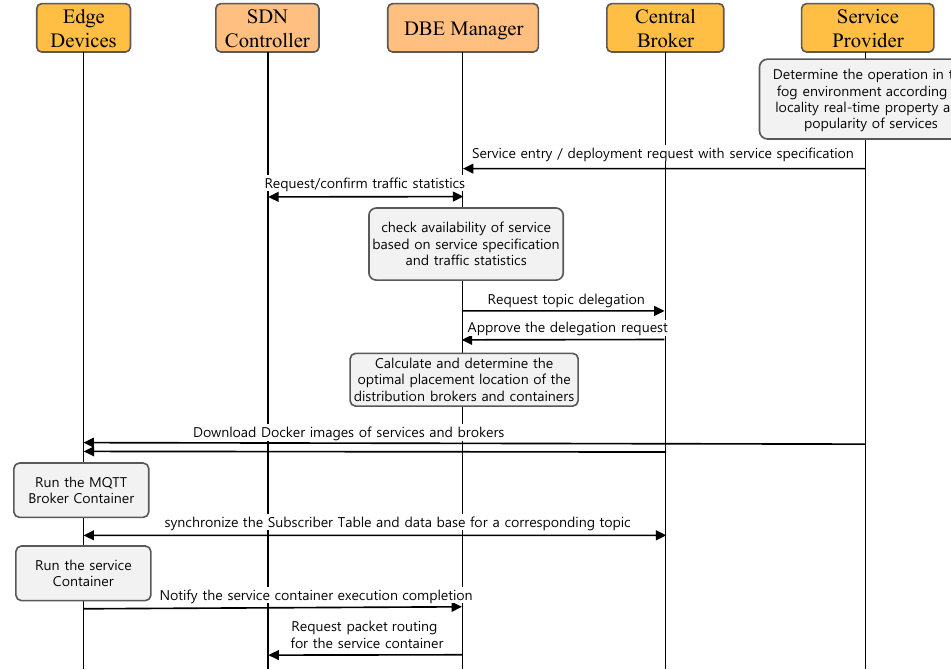
Figure 6. Edge-computing-based topic delegation and service entry